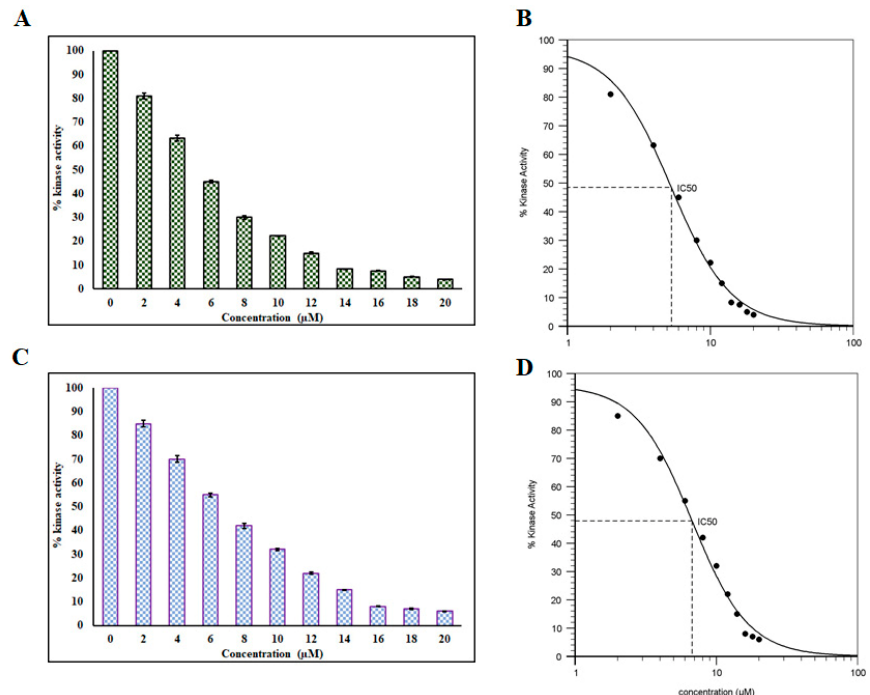
Figure 6. ( A ) ATPase assay showing the e ff ect of DP on the kinase activity of MARK4. ( B ) IC 50 plot of Figure 6. (A) ATPase assay showing the effect of DP on the kinase activity of MARK4. (B) IC 50 plot of DP obtained through the AAT Bioquest calculator [67]. ( C ) ATPase assay depicting the e ff ect of RT on DP obtained through the AAT Bioquest calculator [67]. (C) ATPase assay depicting the effect of RT the kinase activity of MARK4. ( D ) IC 50 plot of RT obtained through the AAT Bioquest calculator on the kinase activity of MARK4. (D) IC 50 plot of RT obtained through the AAT Bioquest calculator [67].